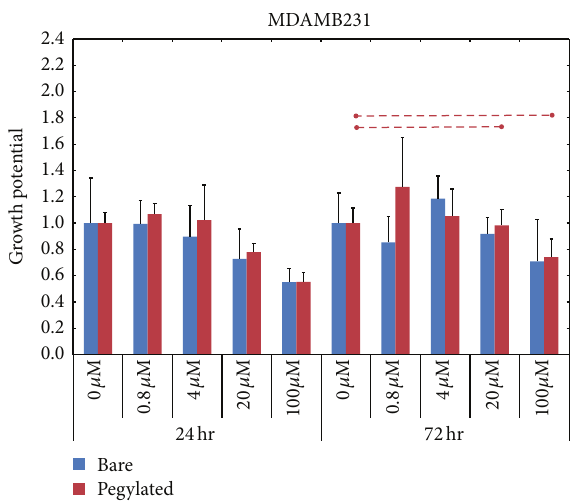
Figure 7: Proliferation of MDA-MB-231 after treatment with bare and pegylated PHAuNPs indicated that the effect was significant only in the case of the pegylated PHAuNPs at 20 𝜇 M and 100 𝜇 M after 72 hours of